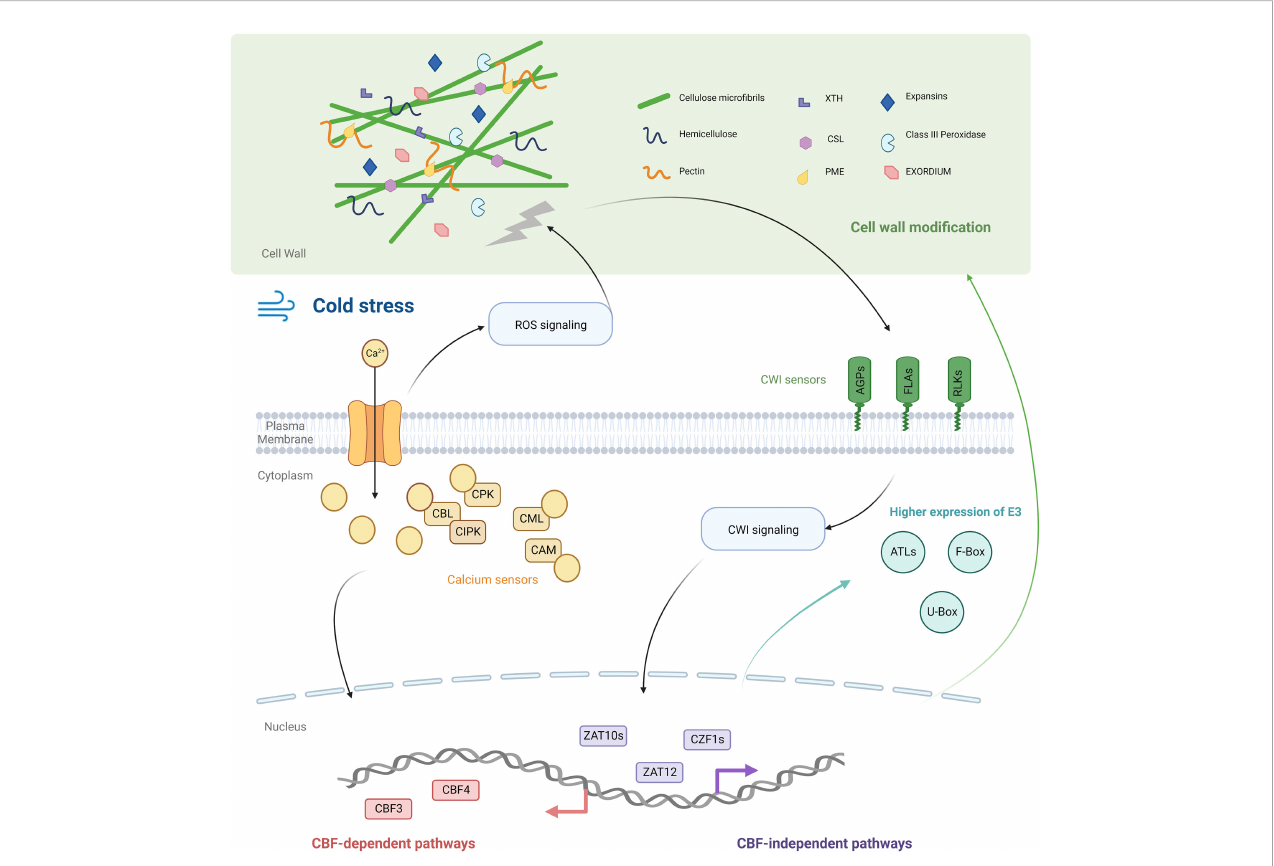
FIGURE 5 Schematic diagram of the cold acclimation mechanism of K. obovata . Cold stress elevated the cytosolic Ca 2+ concentration to generate Ca 2+ signals that were decoded by various calcium sensors. The in fl ux of Ca 2+ led to the production of ROS, which destroyed the cell wall integrity (CWI). The CWI sensors (AGPs and FLAs) perceived this signal and initiated cell well modi fi cation. Genes encoded proteins like PERs, CSLs, XTHs, PMEs, and EXOs modulated wall stiffening/loosening status. K. obovata ’ s Ub system may participate in cold acclimation via recruiting many E3 ligases including ATLs, F- box type, and U-box type E3 ligases. Ca 2+ was upstream of the transcription factor CBFs, and ko CBFs regulated the expression of Cold Acclimation Related Genes (CARGs). Transcription factors in CBF-independent pathways (CZF1 and ZATs) were also hub transcription factors. Thus, CBF-dependent and -independent pathways co-regulated the cold acclimation of K. obovata